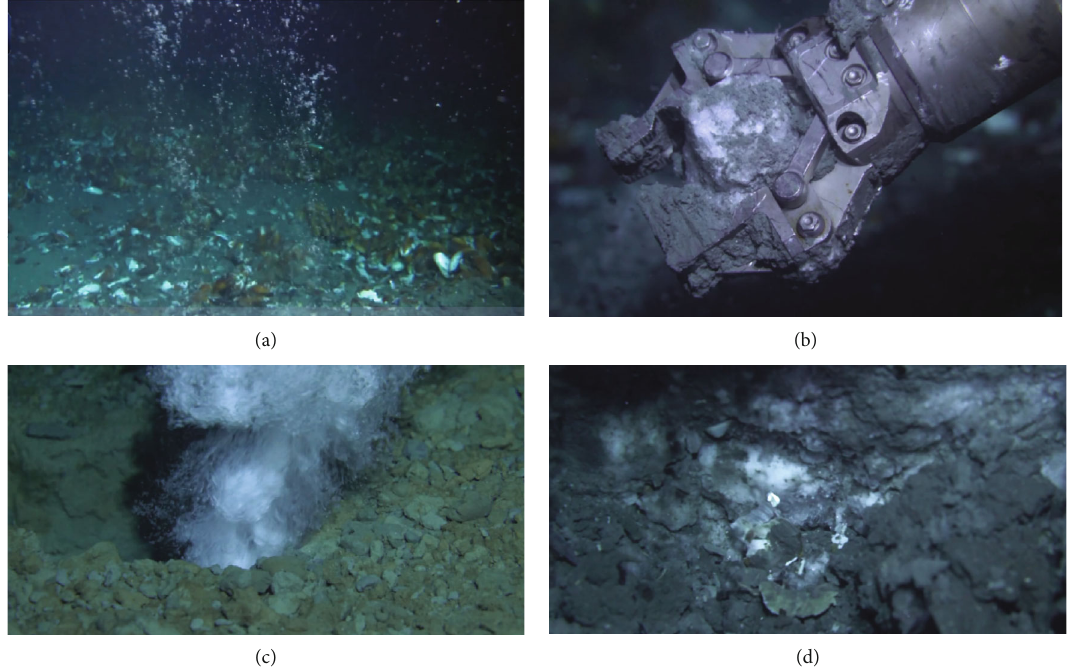
Figure 10: Sea fl oor observations of gas seepages (a, c) and near-surface gas hydrates (b, d) made by ROV “ Haima ” at the newly discovered active cold